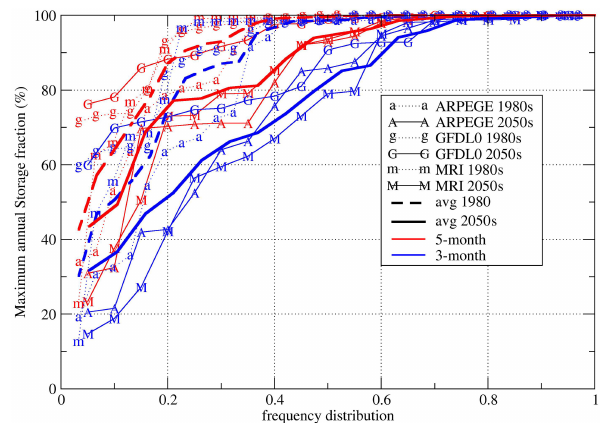
Figure 14. Comparison of the frequency distribution of the maxi- mum annual storage of small farm dams on the Layon in the 1980s and 2050s as simulated using three downscaled climate projections, for the 5-month (red) and 3-month (blue) filling periods. The letter corresponds to the climate model (lower case for 1980s, upper case for 2050s), and the averages in 1980 and 2050 are outlined in thick dashed and solid lines,